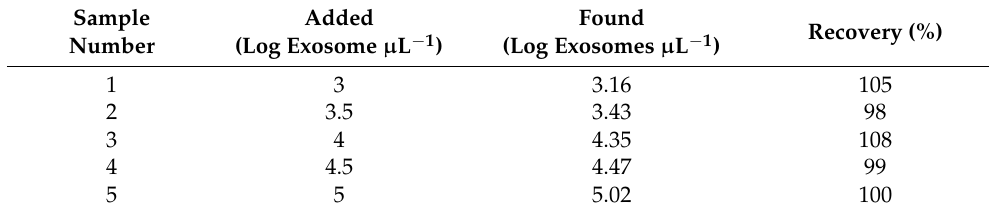
Table 2. The detection results of exosomes in serum using the biosensor.